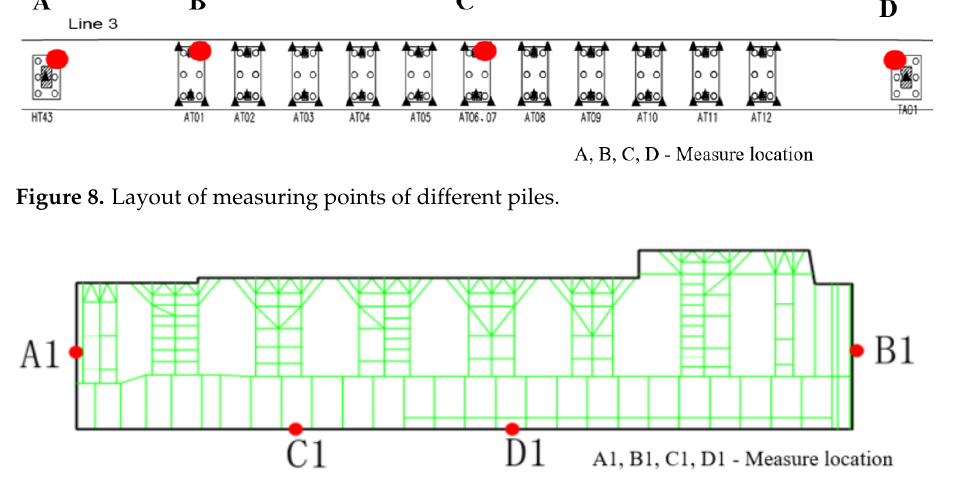
Figure 9. Layout of soil settlement measuring points around the excavation.